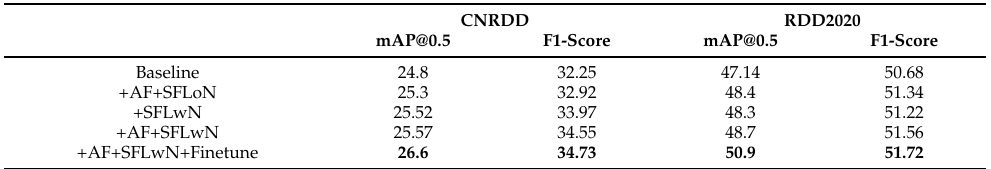
Table 6. Evaluation of the effectiveness of each component. ‘AF’ refers to attention fusion module, ‘SFLwN’ represents salient feature learning module with NAM, ‘SFLoN’ is salient feature learning module without NAM, and ‘FT’ means fine-tuning